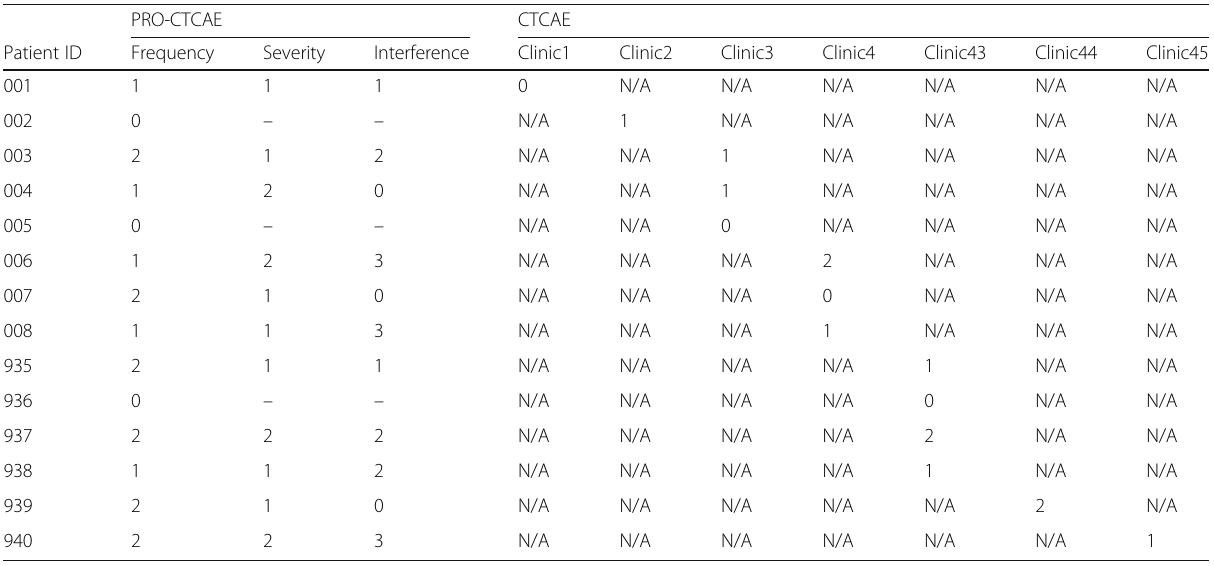
Table 1 Example of data entry